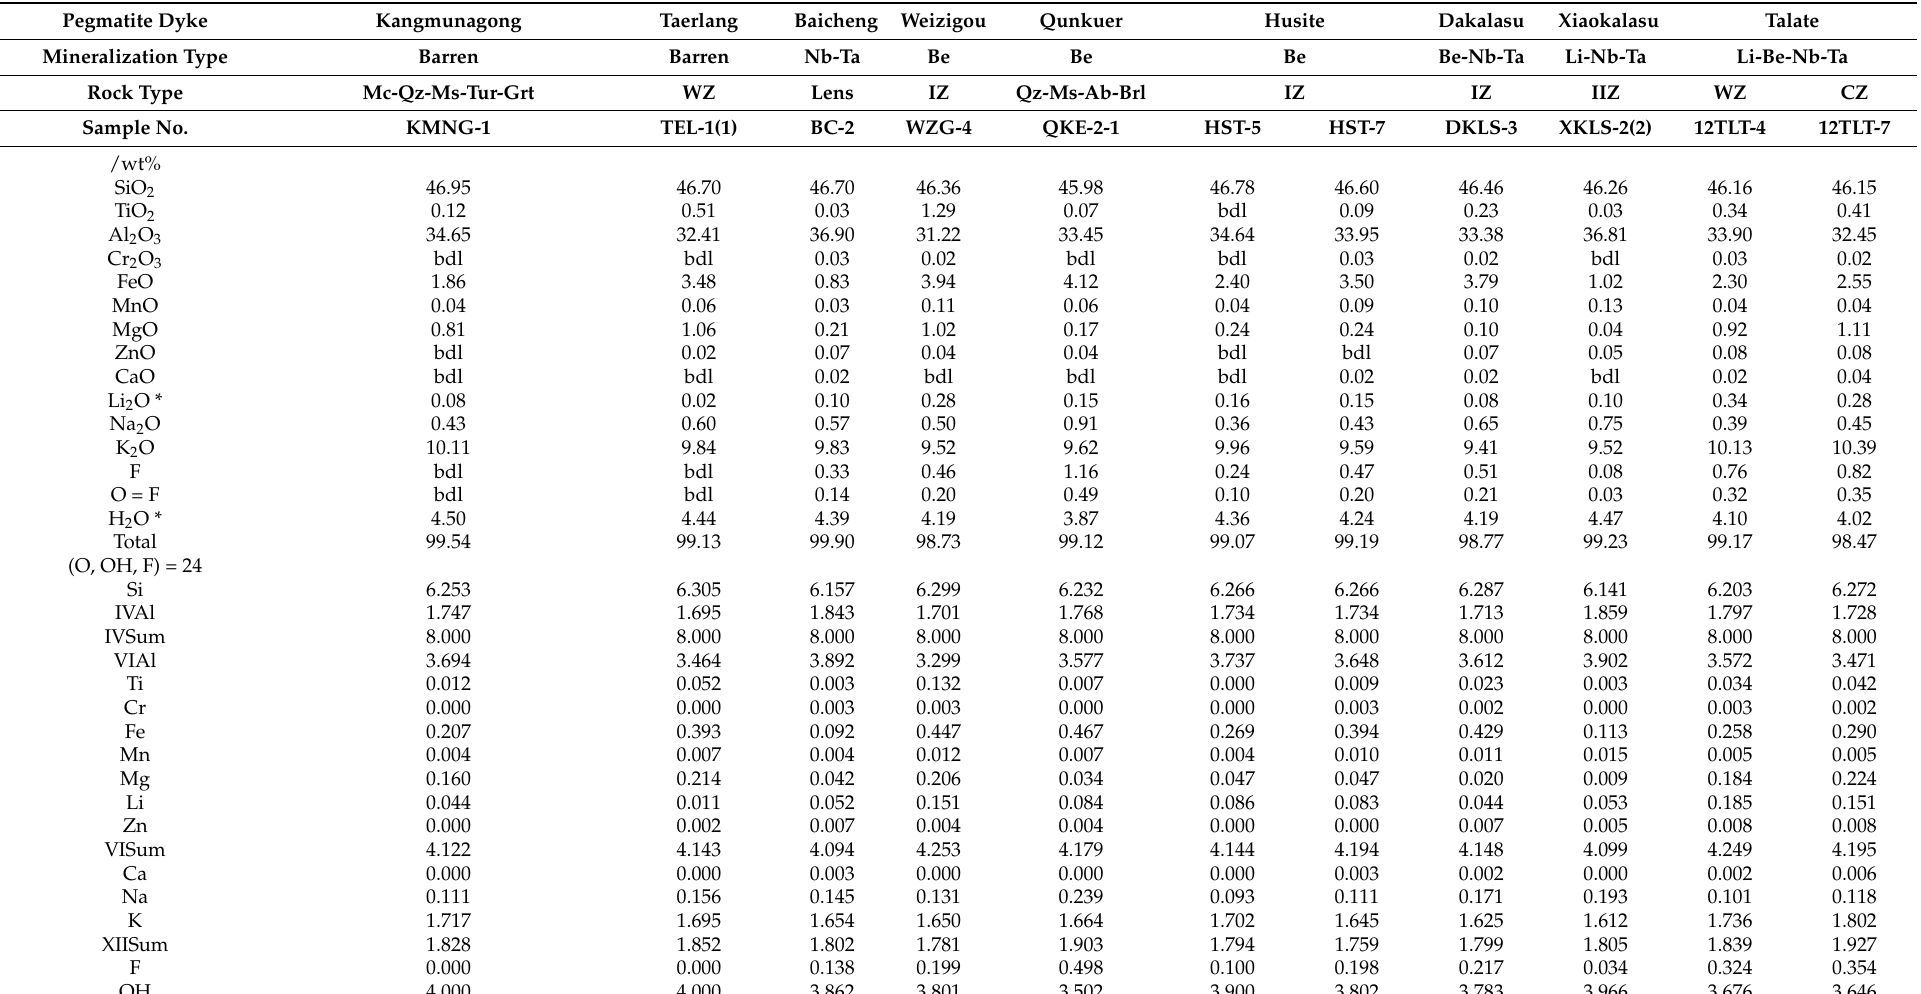
Table 3. The representative EMPA and LA-ICP-MS results of muscovites in the pegmatite dykes of the Chinese